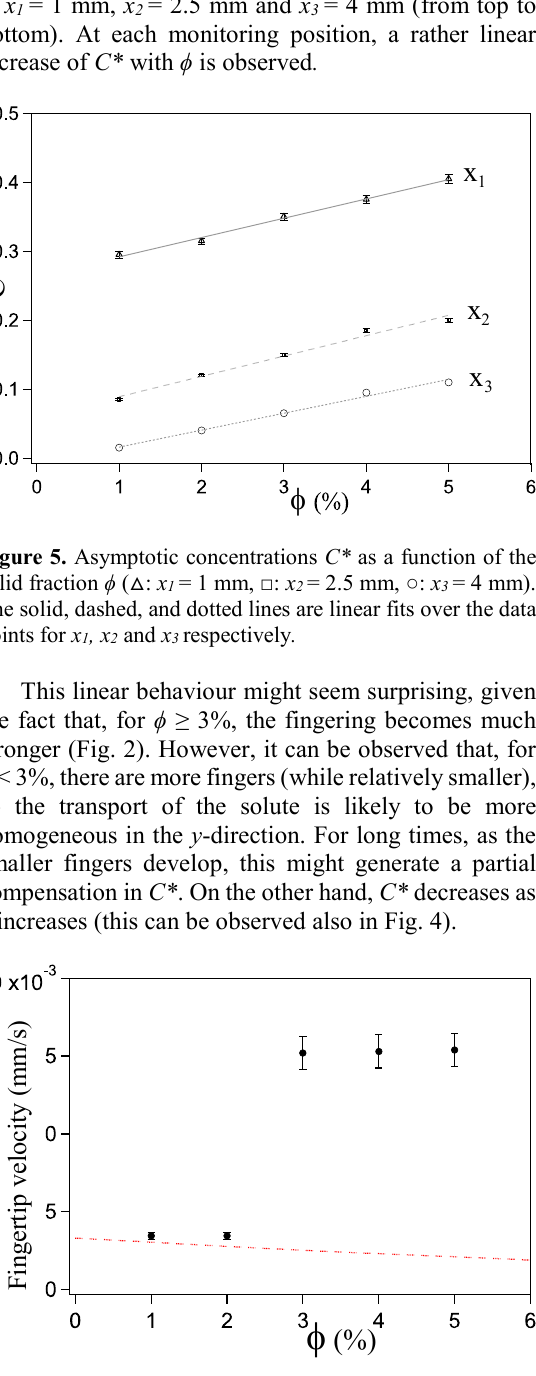
Figure 6. (●): Fingertip upwards characteristic velocity as calculated from the iso-concentration curves of Fig. 2 over different fingers at t = 1440 s. The dashed line is the prediction Figure 4. Time variation of the normalized concentration C’ of Richardson-Zaki [15] for slow buoyant displacement in a ◆ at x 1 = 1 mm ( ▼ : ϕ = 1%, ϕ = ▲ ϕ = ϕ = narrow vessel using our experimental ● ϕ = ). The dashed line illustrates the measurement of the ∎ : 2%, : 3%, : 4%, asymptotic C’ value ≡ C* . Inset shows the time variation of C’ : 5% for ϕ = 3% ( ▲ ), at x 1 = 1 mm (upper curve), x 2 = 2.5 mm (middle curve) and x 3 = 4 mm (lower curve).